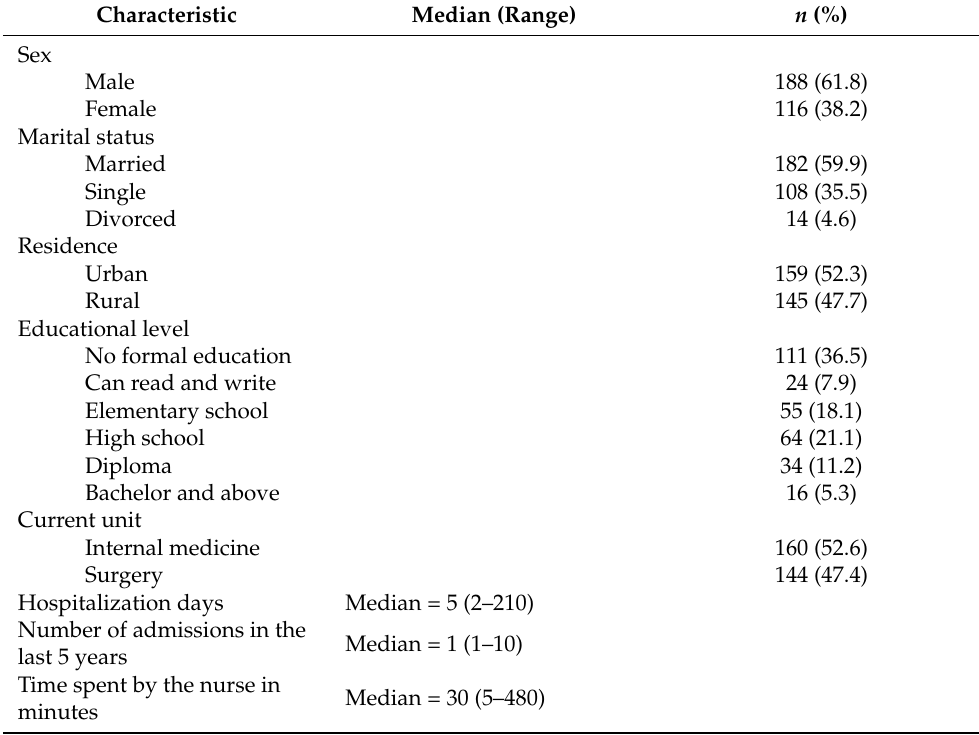
Table 1. Characteristics of participants in the psychometric evaluation of the CBI-16 ( n = 304).